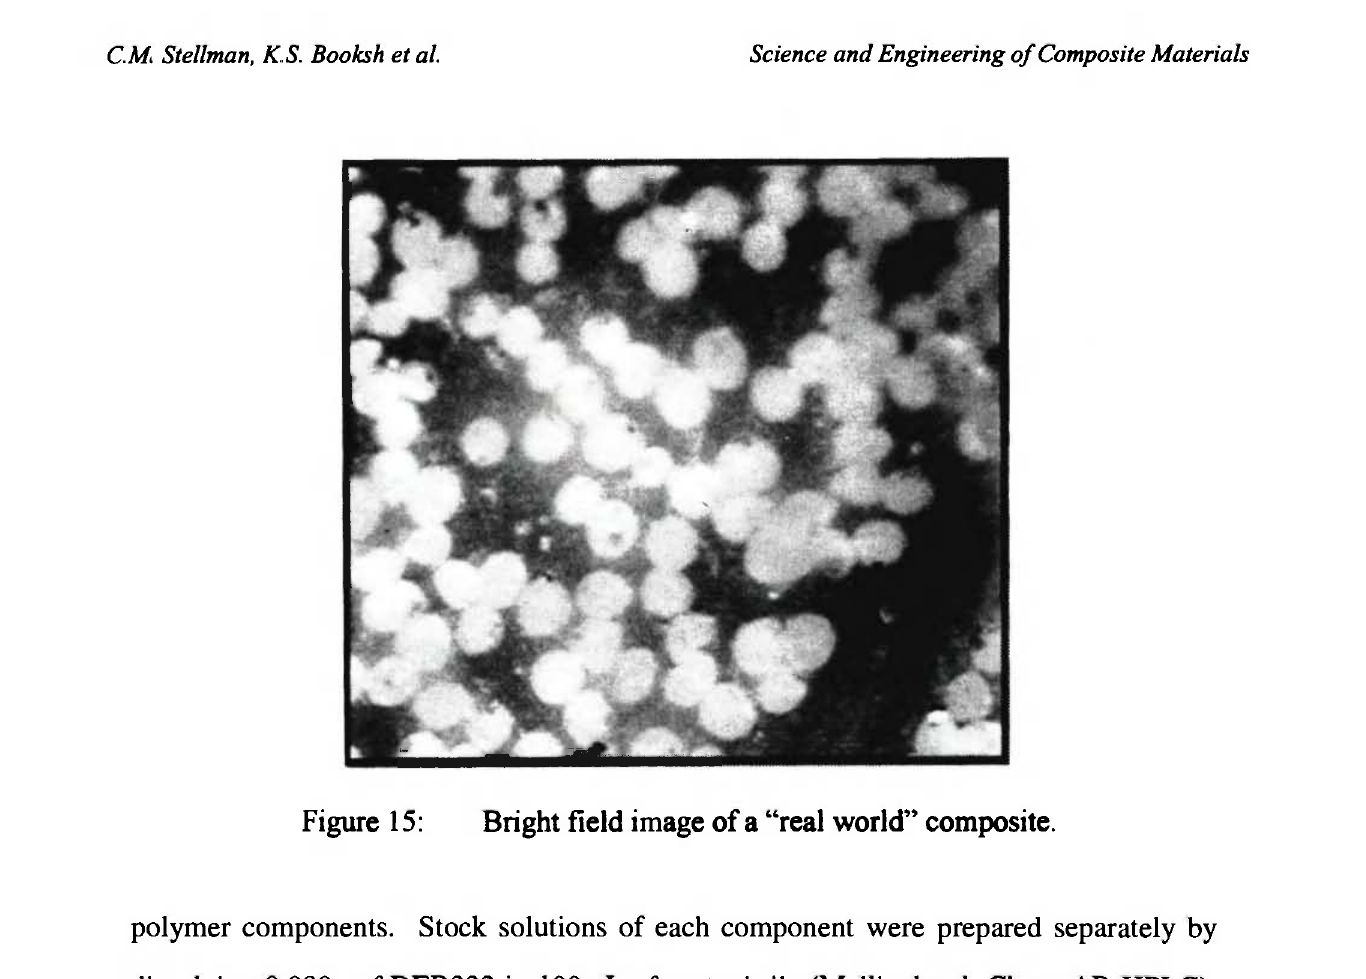
Figure 15: Bright field image of a "real world"